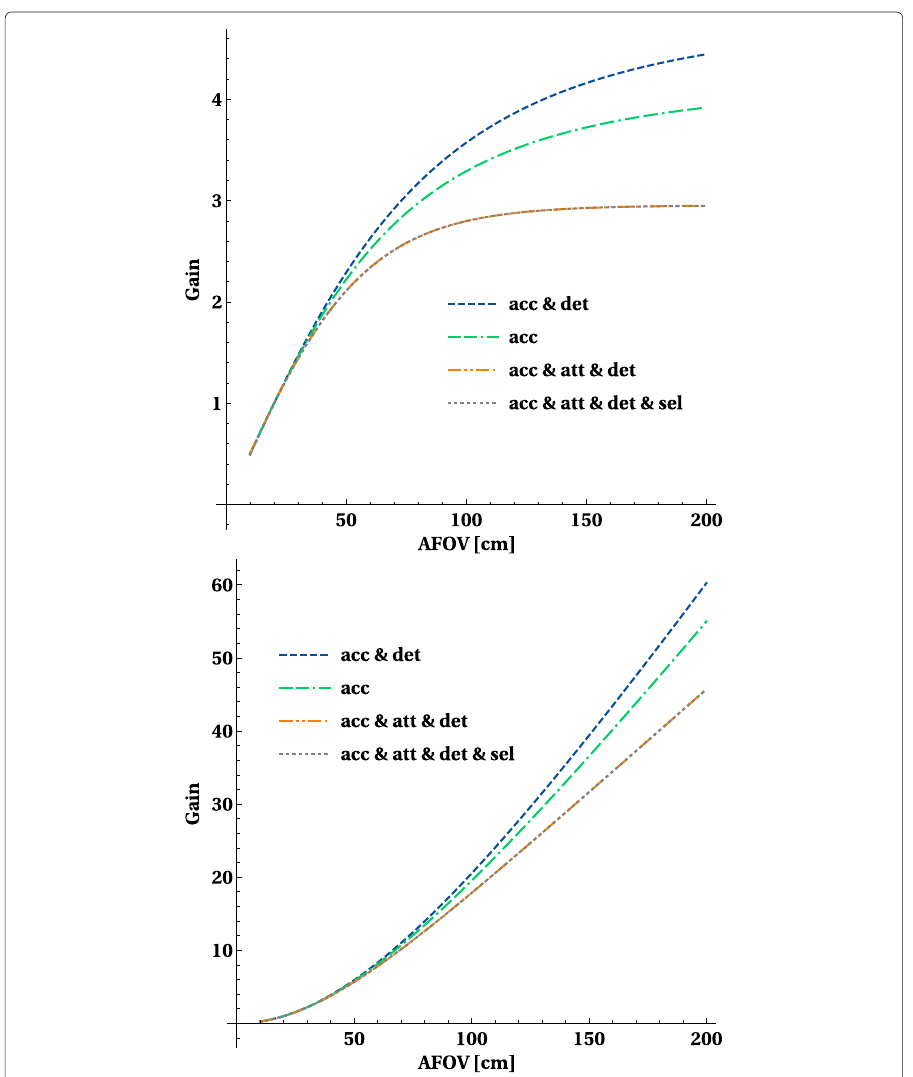
Fig. 7 The sensitivity gain versus a 20-cm axial FOV PET system for a central point source, and for a 200-cm-long line source, the curves for pet and det and sel overlap as the gains remain the same. The gain on the y -axis is the ratio of sensitivity versus the sensitivity of a 20-cm axial FOV PET